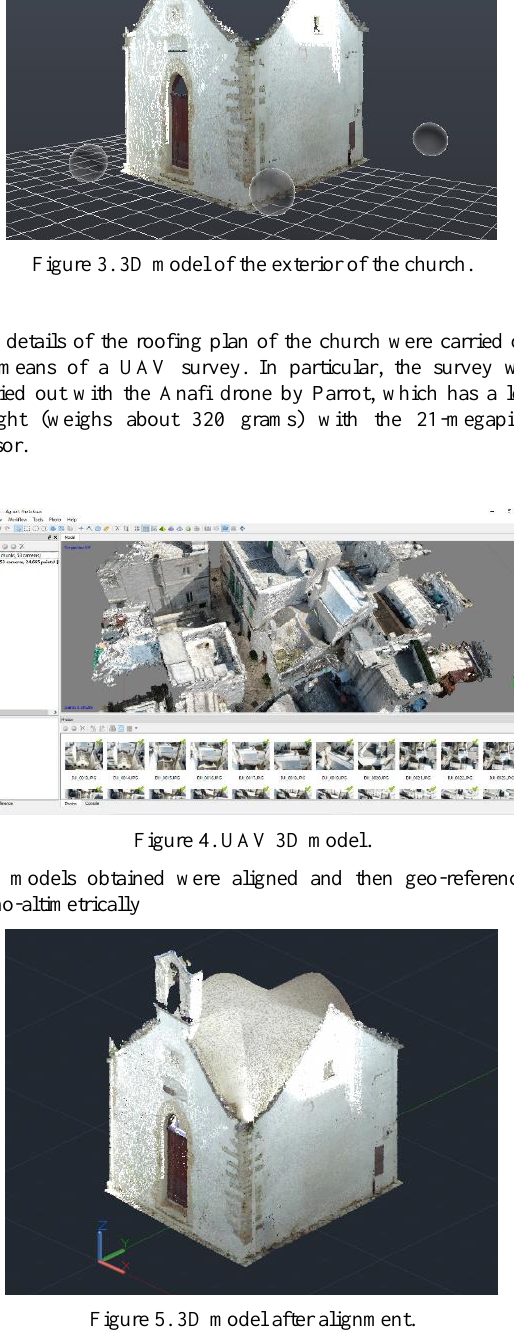
Figure 2. 3D model of the interior of the church.